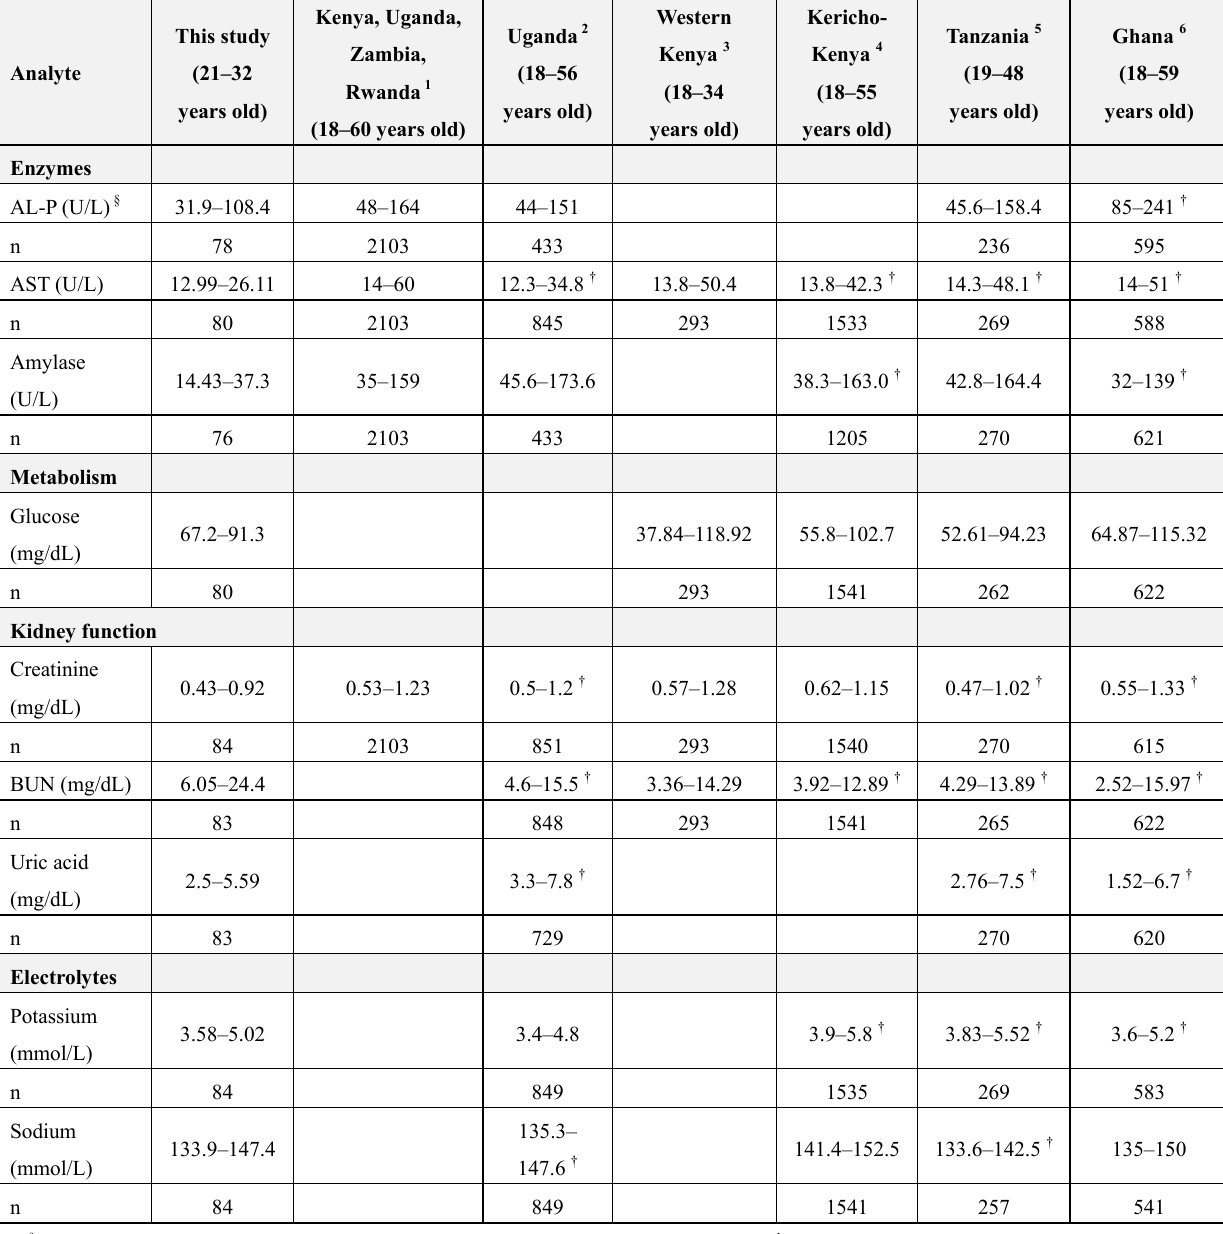
Table 5. Comparison of biochemistry ranges with other studies in Africa: 16–32 years-old.